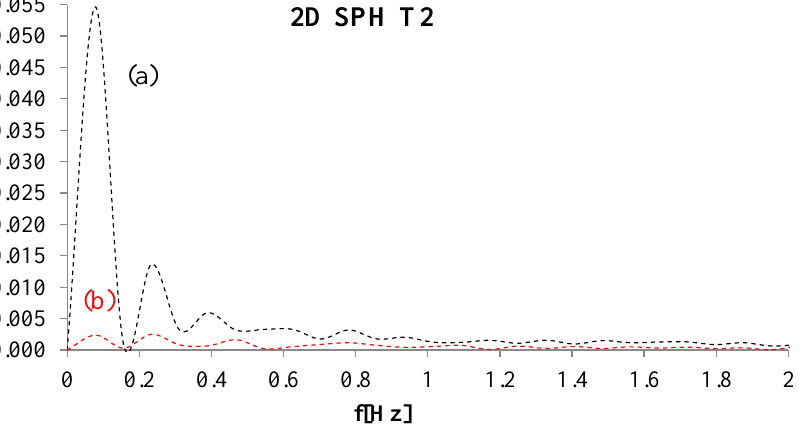
Figure 15. Regime chart for flow configurations with 0.6 < s/y 1 < 1.1. The dashed line shows the approximate boundaries between A and B jump types. The results show the different regions of flow conditions and the occurrence of oscillatory flow conditions between two different jump types characterised by quasi-periodic oscillations (Figure 15). Figures 16–19 show a part of the time series and the amplitude spectra of the pressure evaluated at different locations along the channel the bottom under the hydraulic jumps T1and T2 of Table 1, which represent the two possible oscillating regimes (B-wave and A-wave, respectively). In particular, the pressure was evaluated at a distance of 7, 10, 20 and 100 cm from the time-averaged position of the hydraulic jump toe.